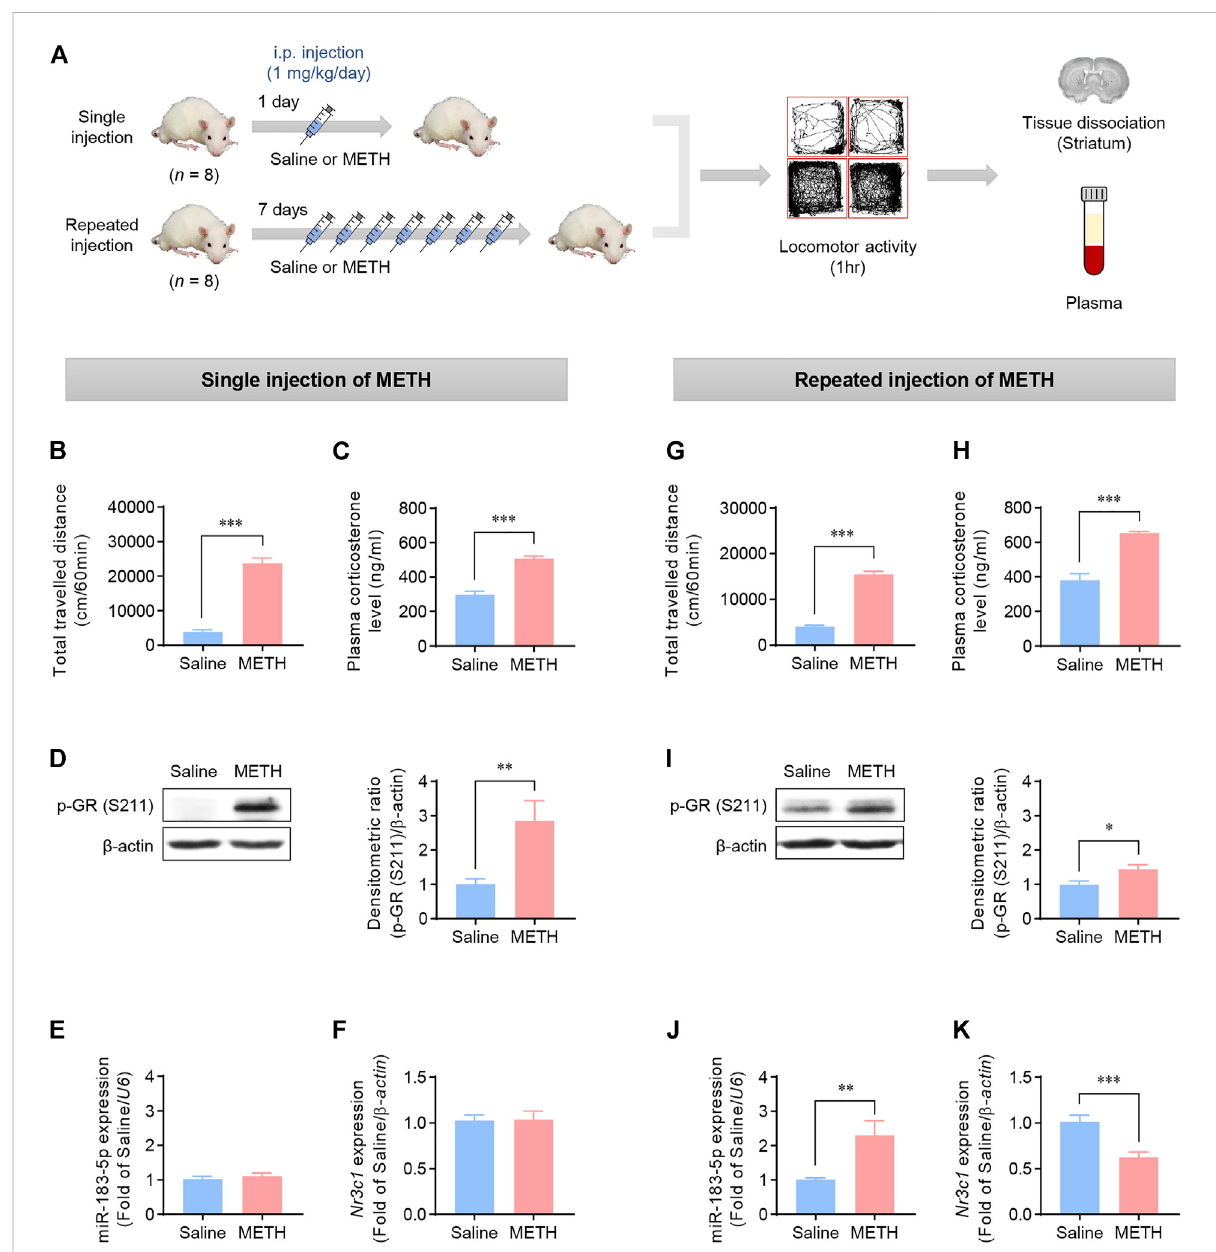
FIGURE 2 Effects of METH injections on the locomotor activity in rats. (A) Flowchart showing an overview of the experimental procedure. Rats were injected with single or repeated METH injections. (B,G) The total travelled distance was recorded 1 h after single or repeated METH injections. Statistical analyses were performed using the Student ’ s t -test. Error bars represent mean ± SEM ( n = 8). *** p < 0.001. (C,H) Plasma corticosterone levels in rats following single or repeated injections of saline or METH. Statistical analyses were performed using the Student ’ s t -test. Error bars representmean±SEM( n =8).*** p < 0.001. (D,I) Westernblotanalysisshowingp-GR(S211)expressioninratstriatum.Thebandswerenormalizedto β -actin. Quanti fi cation of the relative blot intensity of proteins was performed using ImageJ software. Data are presented as the fold change relative tothesalinegroup.StatisticalanalyseswereperformedusingtheStudent ’ s t -test.Errorbarsrepresentmean±SEM( n =8).* p < 0.05,** p < 0.01. (E,J) qRT-PCR analysis of miR-183-5p expression. The value was normalized to the U6 level. Data are presented as the fold change relative to the saline group. Statistical analyses were performed using the Student ’ s t -test. Error bars represent mean ± SEM ( n = 8). ** p < 0.01. (F,K) qRT-PCR analysis of Nr3c1 . The level was normalized to the β -actin level. Data are presented as the fold change relative to the saline group. Statistical analyses were performed using the Student ’ s t -test. Error bars represent mean ± SEM ( n = 8). *** p <